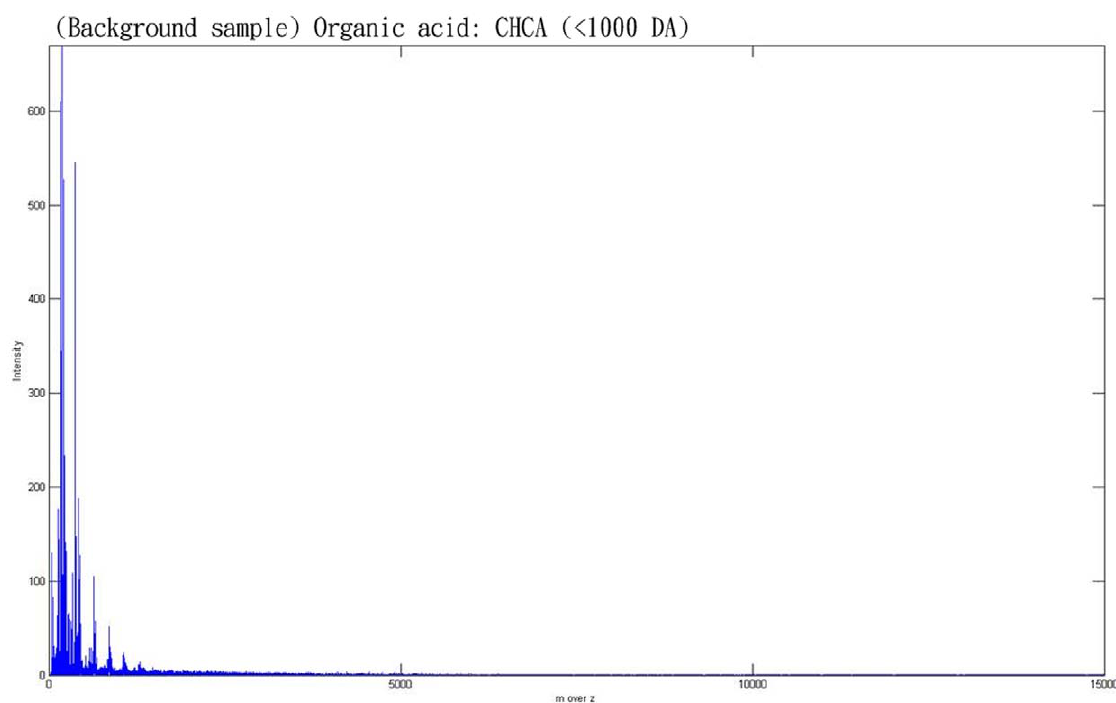
Figure 9. The spectrum of background. The organic acid used in the experiment is CHCA, which has a molecular weight of less than 1000 Da. doi:10.1371/journal.pone.0012493.g009 peaks located in the this low region are less significant. As shown in detects fewer peaks between 2000Da and 6000Da but detects Table 2, SepcAlign has a disadvantage when preprocessing such more peaks between 10 kDa and 15kDa. Overall, HHTMass2 is data and HHTMass is able to conquer this problem. HHTMass1 more uniform when examining the low and high regions. This